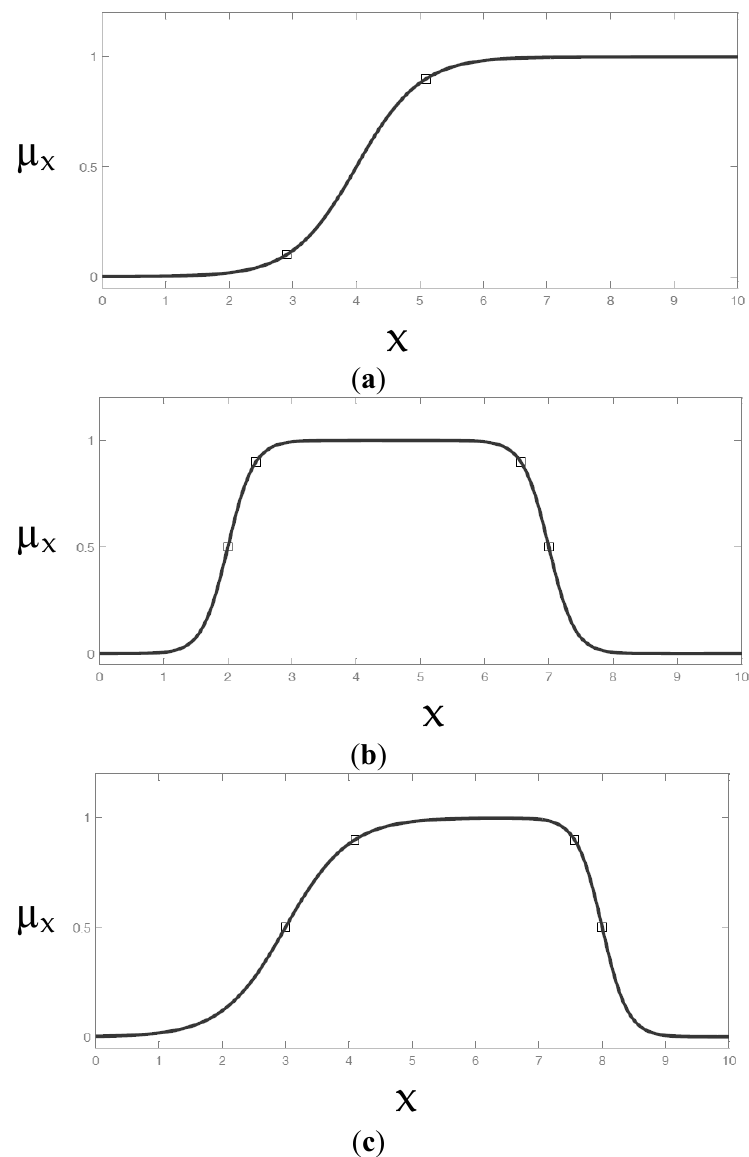
Figure 8. ( a ) Sigmoid (Sig) membership function; ( b ) Dsig membership function; ( c ) Psig membership